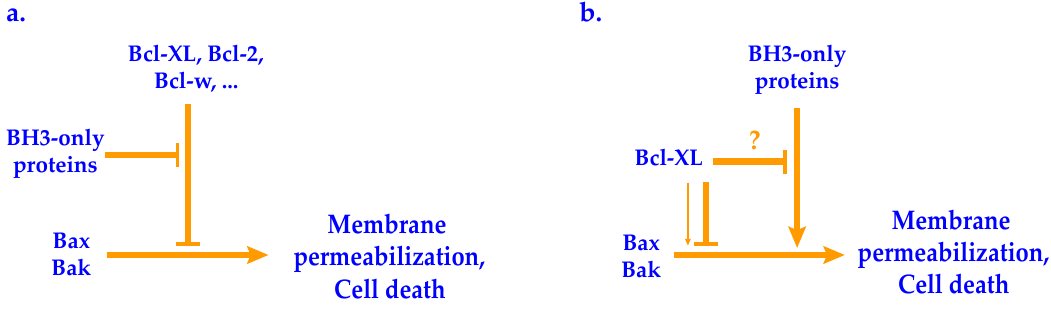
Figure 3. Two modes of Bcl-2 family proteins action observed in yeast model systems. ( a ) Bax or Bak are expressed as constitutively active cells killing proteins. Their activity is inhibited by coexpression of antiapoptotic protein (Bcl-XL, Bcl-2, Bcl-w). Coexpressed BH3-only proteins inhibit Bax-inhibiting activity of antiapoptotic proteins, resulting in active Bax or Bak. (e.g., [65]) ( b ) Bax requires activation by BH3-only proteins to become an active cells killing protein. (Such activation can also be achieved by introducing a point mutation into Bax). Bcl-XL appears to both promote mitochondrial targeting of Bax and inhibition of pore formation [63].